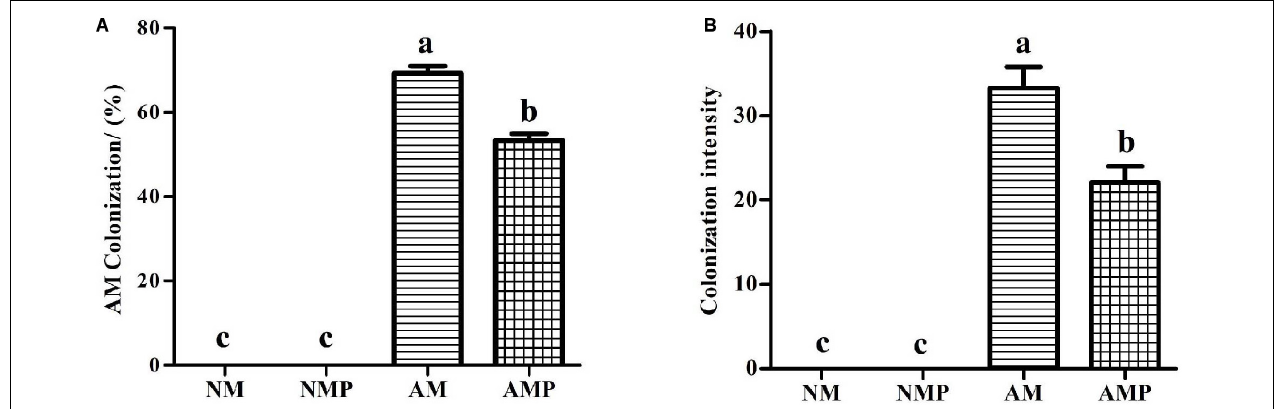
FIGURE 1 | AM colonization (A) and colonization intensity (B) in the roots of common vetch. NM = uninoculated with S. tortuosa , AM = inoculated with S. tortuosa , NMP = NM inoculated with C. lentis , and AMP = AM inoculated with C. lentis . Different lowercase letters on the bars means there is significant difference across treatments at P < 0 . 05 by Tukey’s HSD